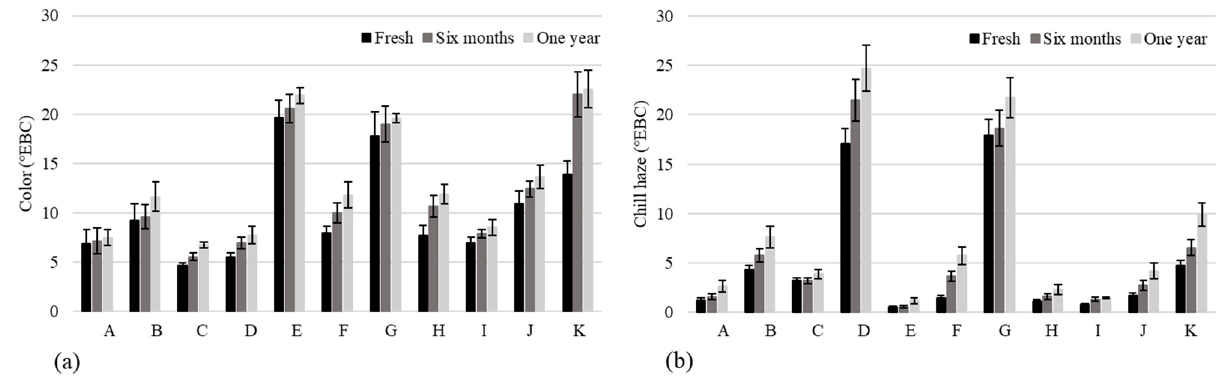
Figure 1. Evolution of color (°EBC) ( a ) and chill haze (°EBC) ( b ) of 11 commercial NABLABs through one year of storage at 20 °C in the dark.